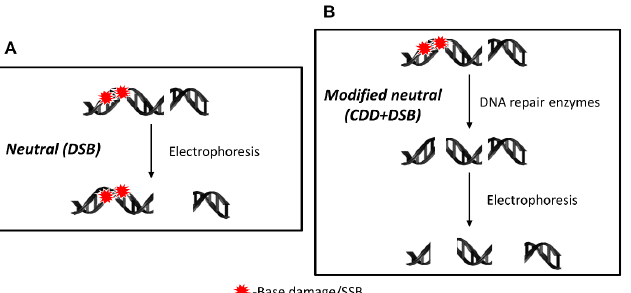
Figure 1. Schematic of the DNA damage detected by different versions of the neutral comet assay. ( A ) Under neutral comet assay conditions, only the analysis and detection of DSBs will be achieved, with no ability to resolve residual DNA base damage and/or SSB in proximity to the DSB. ( B ) In the EMNC assay, following cell lysis, the DNA is treated with recombinant DNA re- pair enzymes that recognize and incise the DNA at unrepaired DNA base damage sites to create additional DSBs that can then be detected following